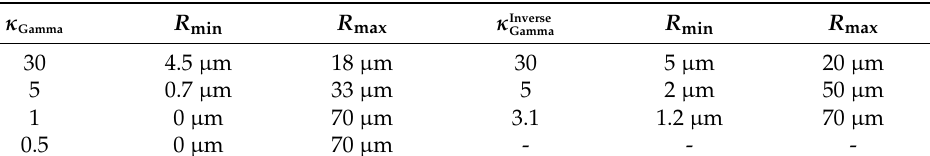
Table 1. Minimum and maximum radii for which the initial Gamma (32) and Inverse Gamma (33) PDFs are numerically zero. Outside from the radius interval [ R min , R max ] , the PDFs are less than (cid:101) = 0.001 max ( f ( R 2 )) . ×